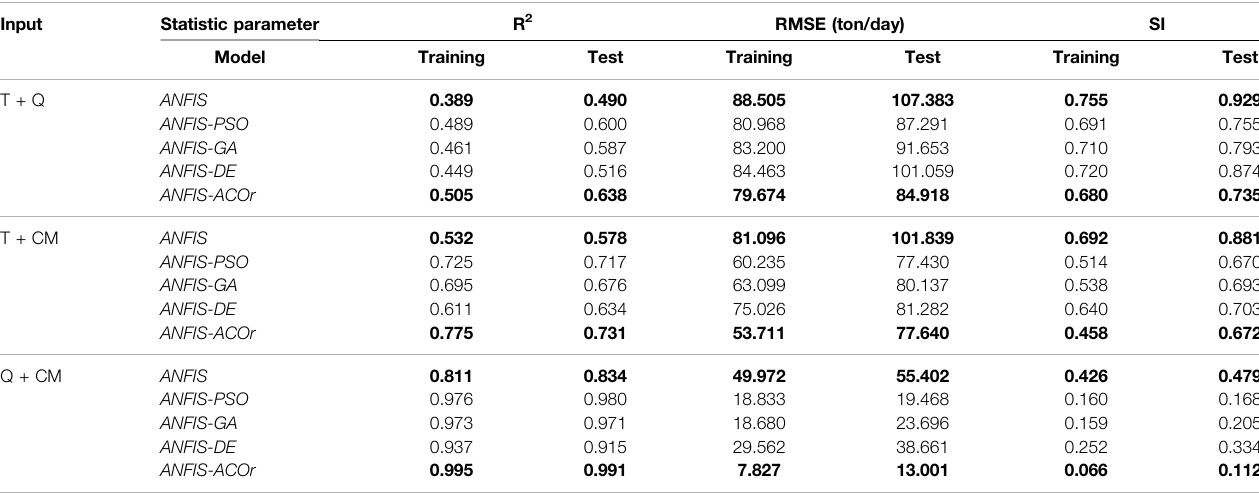
bold values are the highest achieved values for each